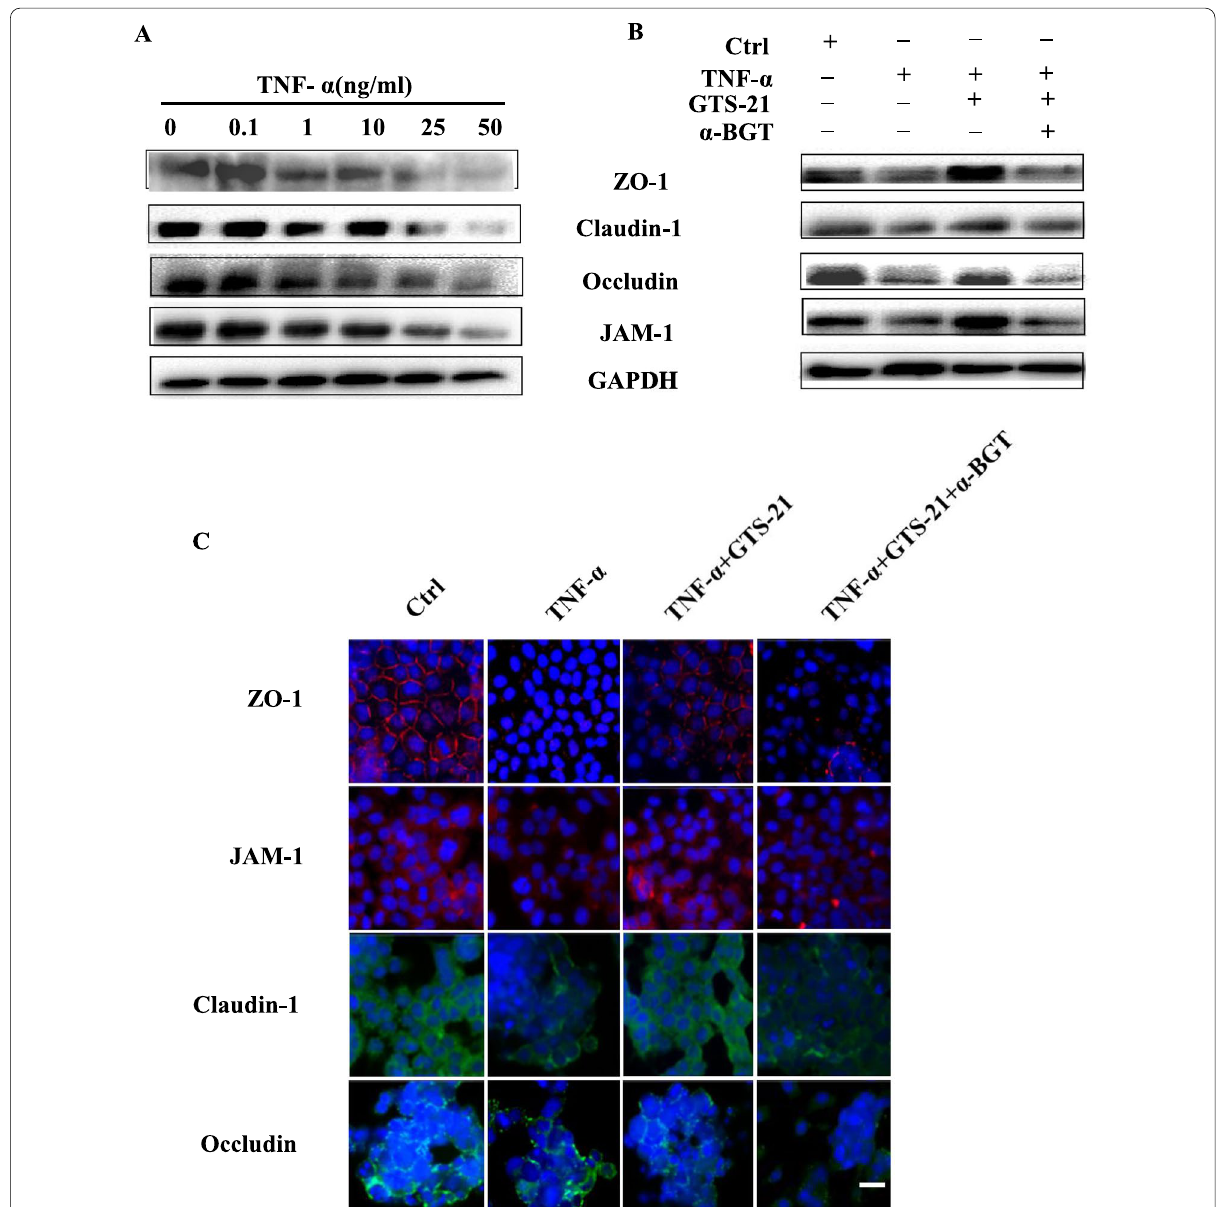
Fig. 4 GTS-21 improves the tight junction (TJ) proteins expressions and distribution in Caco2 monolayers. A Western blot analysis of Caco2 cellular TJ proteins (ZO-1, claudin-1, occludin, JAM-1) expressions level in each group with stimulation of different concentrations of TNF-α for 24 h. B Western blot analysis of Caco2 cellular TJ proteins (ZO-1, claudin-1, occludin, JAM-1) expressions level in different groups. C Representative immunofluorescence of ZO-1 and JAM-1 (red), claudin-1 and occludin (green) in Caco-2 monolayers. (DAPI nuclear staining). Magnification, Scale bar, 100